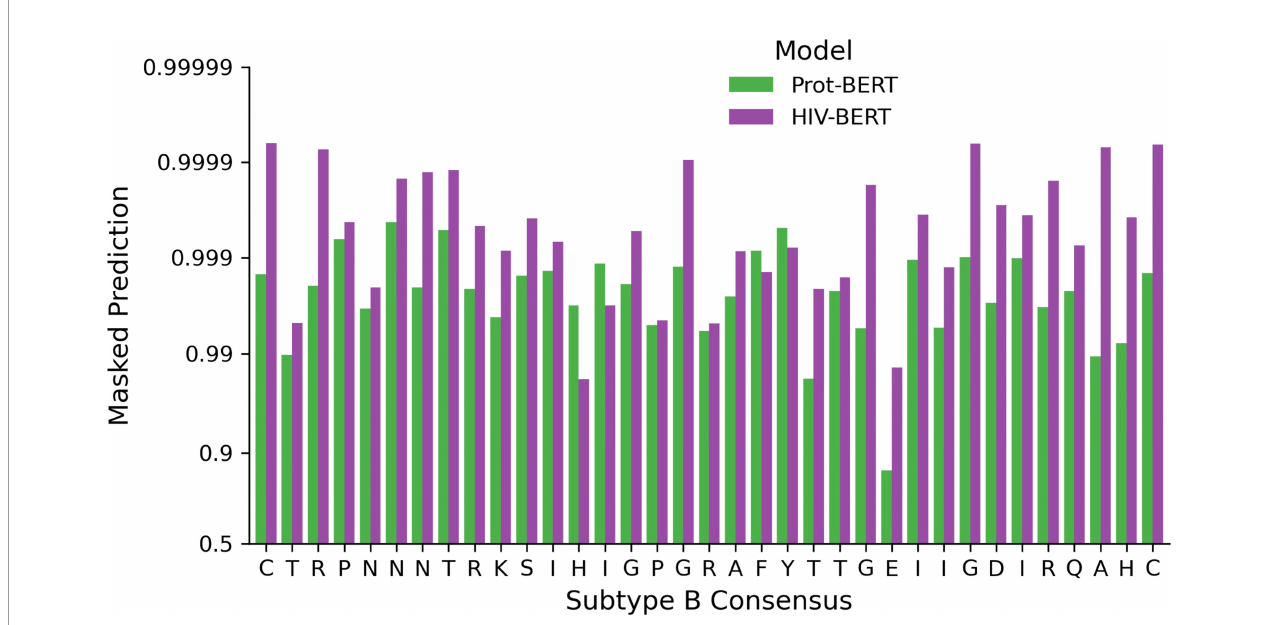
FIGURE 5 | Full genome pretraining of the Prot-BERT model increases HIV-1 sequence awareness. The probability of each consensus amino acid of the V3 loop when performing masked prediction task. Green bars represent the prediction from the Prot-BERT model and red bars represent the HIV-BERT